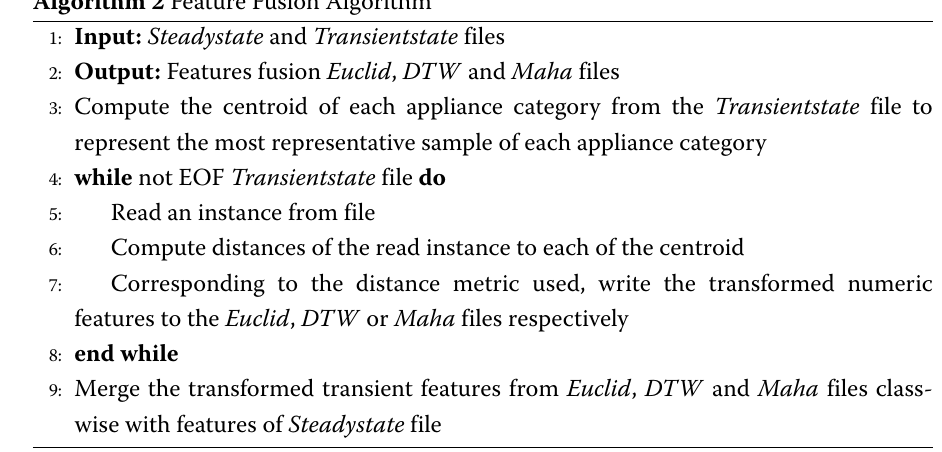
Algorithm 2 Feature Fusion